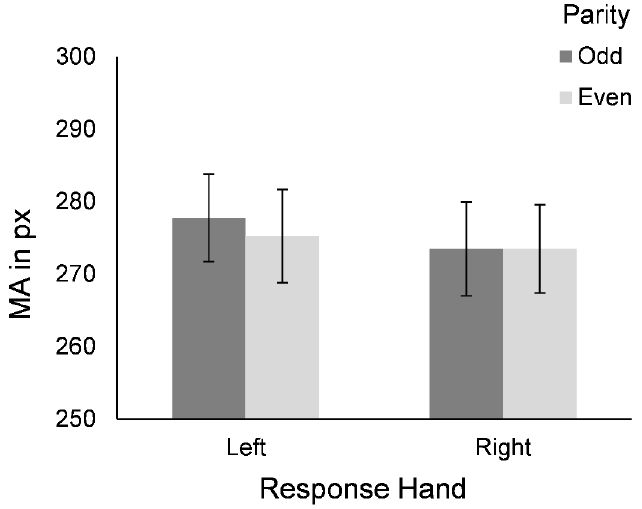
Figure 4. Hand-based MARC effect indicated by an interaction between parity and hand for movement amplitude in the magnitude classification